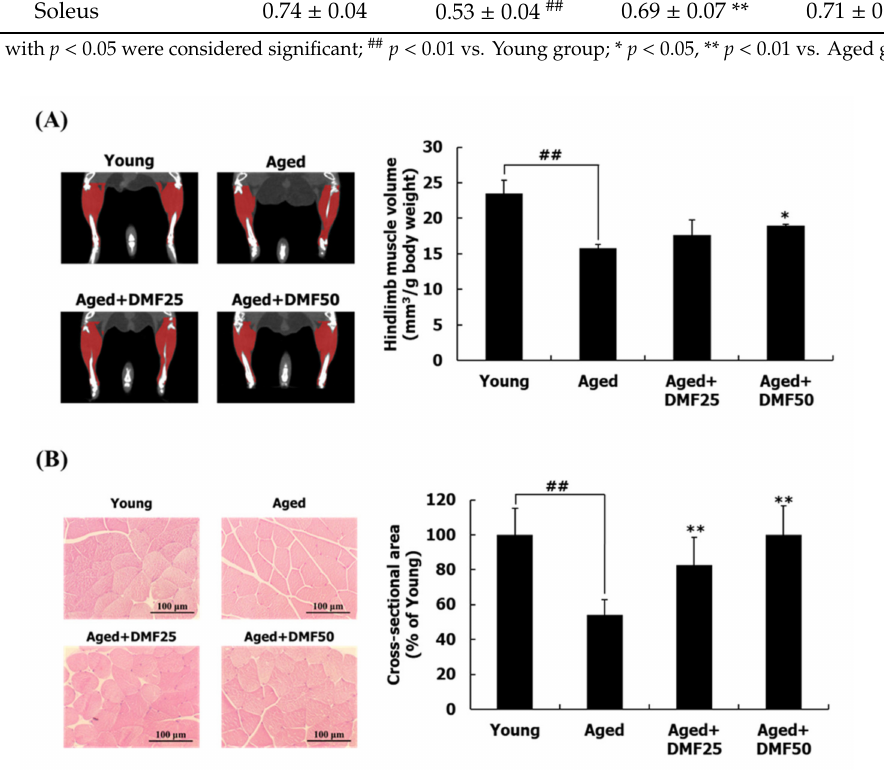
Figure 3. E ff ect of DMF on body composition. ( A ) Hindlimb volume. ( B ) The cross-sectional area of the gastrocnemius muscle fiber (magnification, × 200). Muscle volume was normalized to the body weight. Results are presented as mean ± SD; ## p < 0.01 vs. Young group; * p < 0.05, ** p < 0.01 vs. Aged